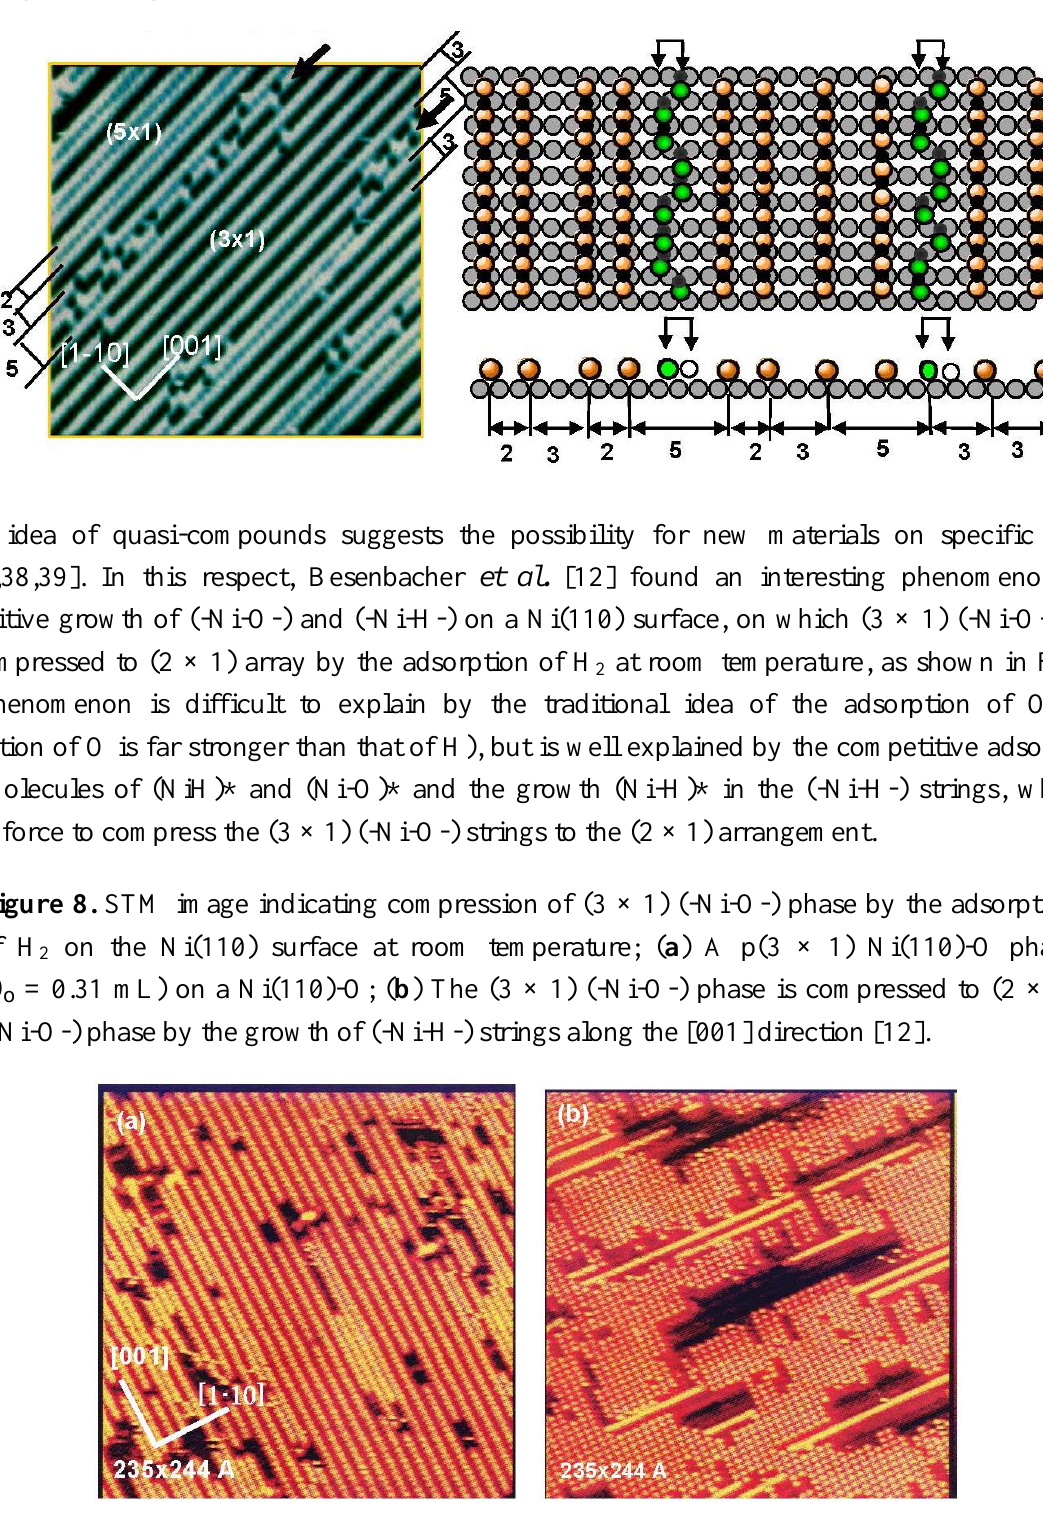
Figure 7. Self-assembly of (-Ag-O-) strings on a Ag(110) susrface make (n × 1) structure. A (-Ag-O-) chain along the phase bounday of the (3 × 1) domains undergoes fluctuation between the two energetically equivalent sites, which indicates weak internal bonding of (-Ag-O-) strings [41].